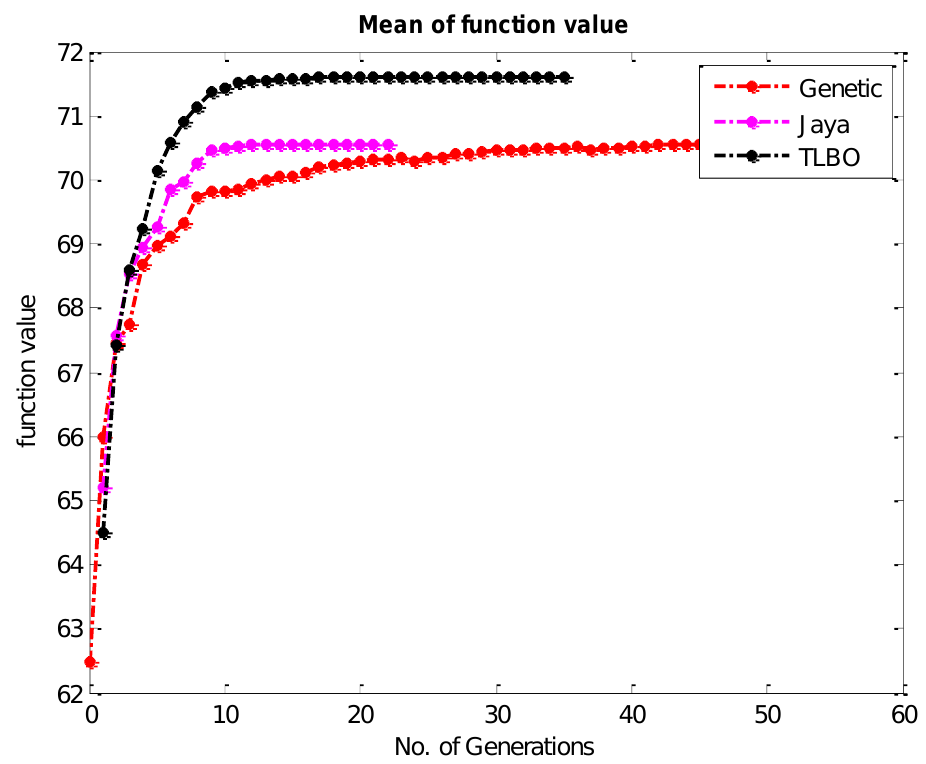
Figure 5. Comparative Convergence plot for the hardness by TLBO JAYA and Genetic Algorithm.